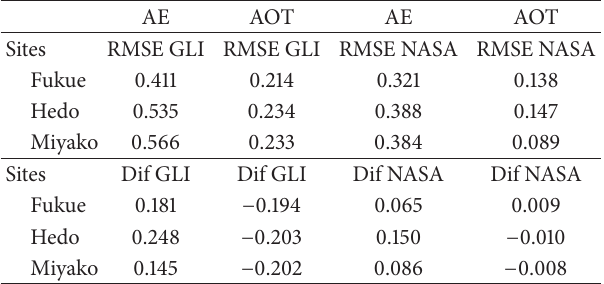
Table 1: Error analyses showing the root mean square error (RMSE) between the ground data and the satellite derived data for the MODIS-GLI algorithm (GLI RMSE) and the MODIS-NASA algorithm (NASA RMSE), and the simple differences between the ground data and the MODIS-GLI (GLI Dif), then the MODIS- NASA (NASA Dif) satellites’